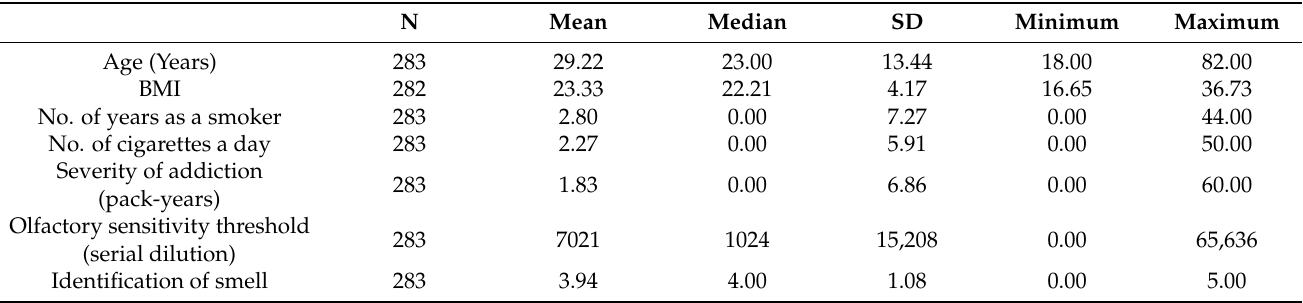
Table 1. Characteristics of the study